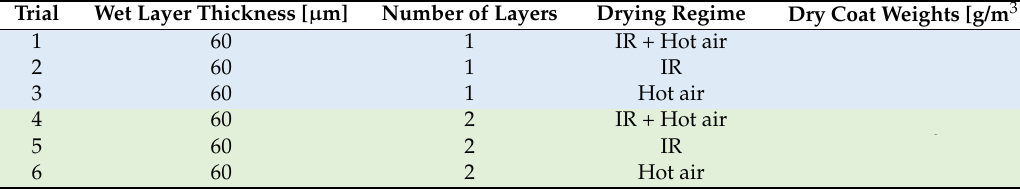
Table 2. Design of coating trial with defined layer thickness, number of layers, drying regimes and coat weights. Trials with one layer of chitosan are indicated by trial numbers 1, 2 and 3 (light blue) and trials with two chitosan layers are indicated by 4, 5 and 6 (light